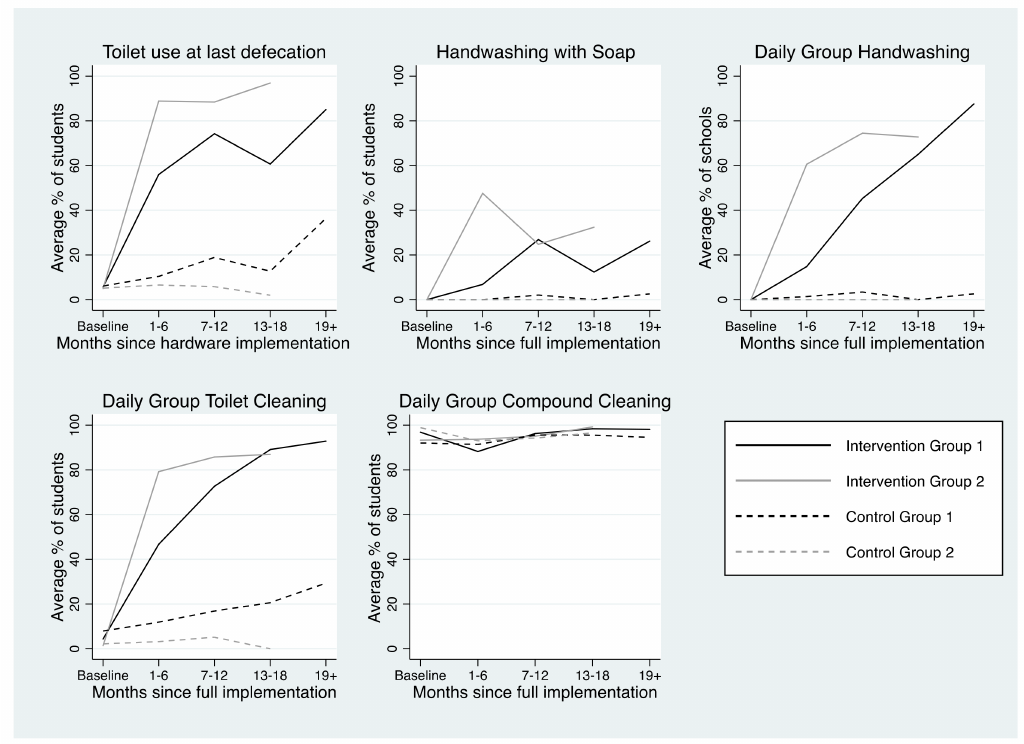
Figure 3. Achievement of project outcomes by time since project implementation, stratified by intervention and implementation groups.